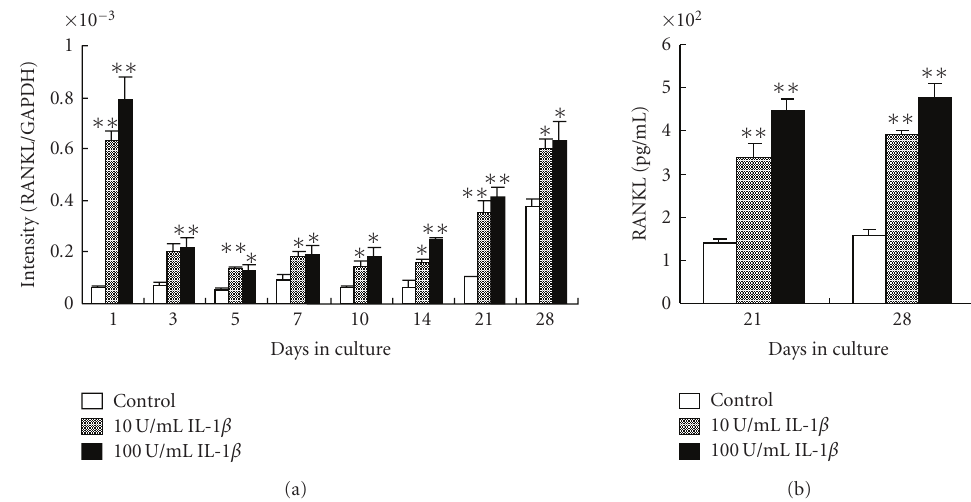
Figure 1: E ff ect of IL-1 β on RANKL gene and protein expression. (a) Cells were cultured with 0, 10, or 100 U/mL IL-1 β and RANKL gene expression was determined by real-time PCR on days 1, 3, 5, 7, 10, 14, 21, and 28 of culture. (b) RANKL protein expression determined by ELISA on days 21 and 28. Each bar indicates the mean ± SD from four separate experiments. ∗ P < . 05, ∗∗ P < . 01 for IL-1 β treatment versus the